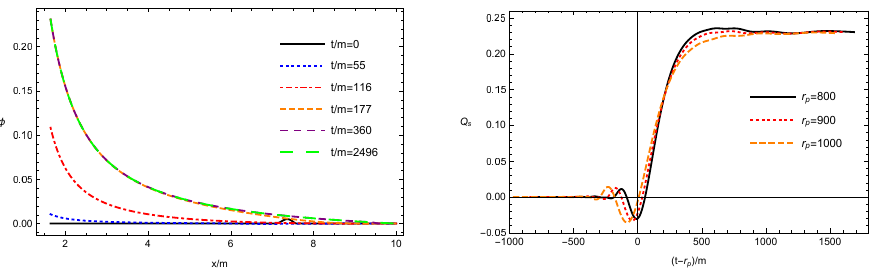
Figure 5 . The temporal evolutions of the scalar field for an initial BBH with a mass below the threshold value. Left panel: spatial distribution of the scalar field φ at different time slices. Right panel: the scalar charge Q s as a function of t r p at large r p . −